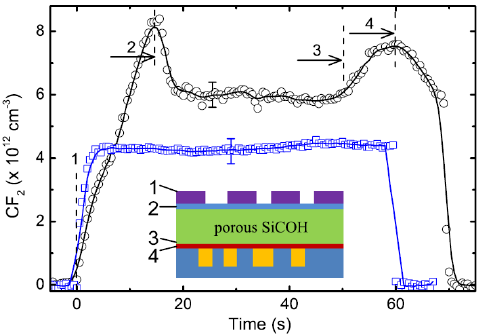
Figure 28. Time dependent CF 2 concentration while etching blank porous SiCOH (squares) and structured porous SiCOH (circles) using a CF 4 plasma with a rf power of 1000 W, bias power of 60 W, 1.33 Pa total pressure, and a gas flow rate of 25 sccm. The inset shows a schematic diagram of the lateral cross-section of a structured porous SiCOH wafer. The numbers in the upper curve represent the numbers given as the inset [59], Reproduced from [59], with the permission of AIP Publishing.